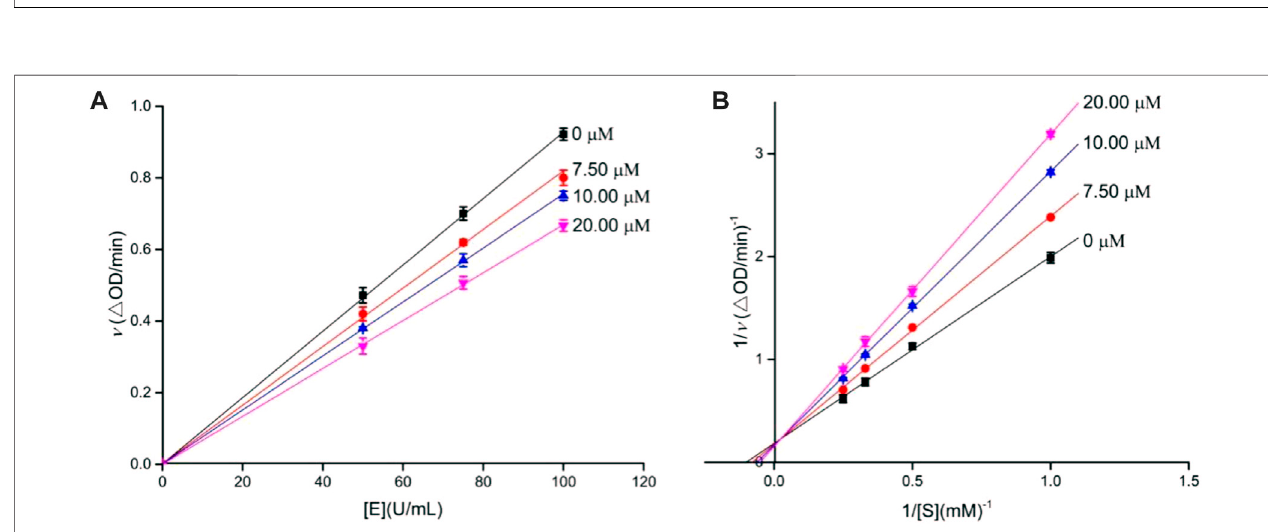
FIGURE 1 | Inhibition kinetics of analog 4i against α -glucosidase. (A) Plots of the enzymatic reaction rate vs. α -glucosidase concentration with or without the presence of analog 4i ; (B) Lineweaver – Burk plots of enzymatic reaction rate vs . substrate concentration with or without the presence of analog 4i .